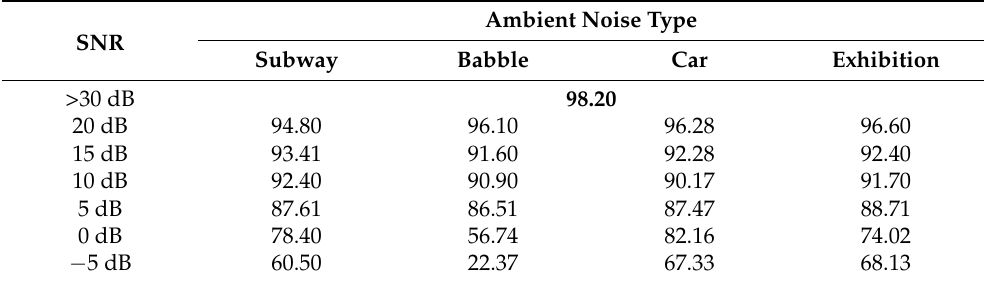
Table 2. CNN-based VAD utterance-level test accuracy [%] vs. SNR–CENSREC-1-C subset A.